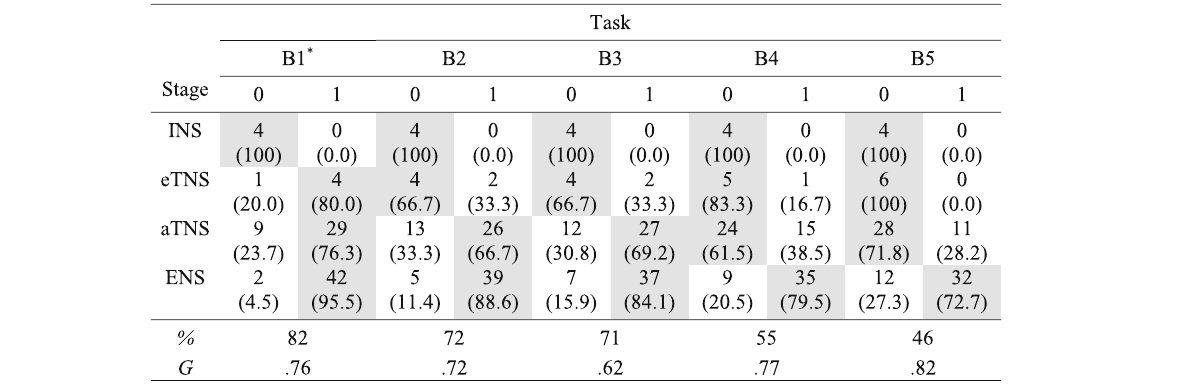
Table 2 Association between performance on bar tasks and